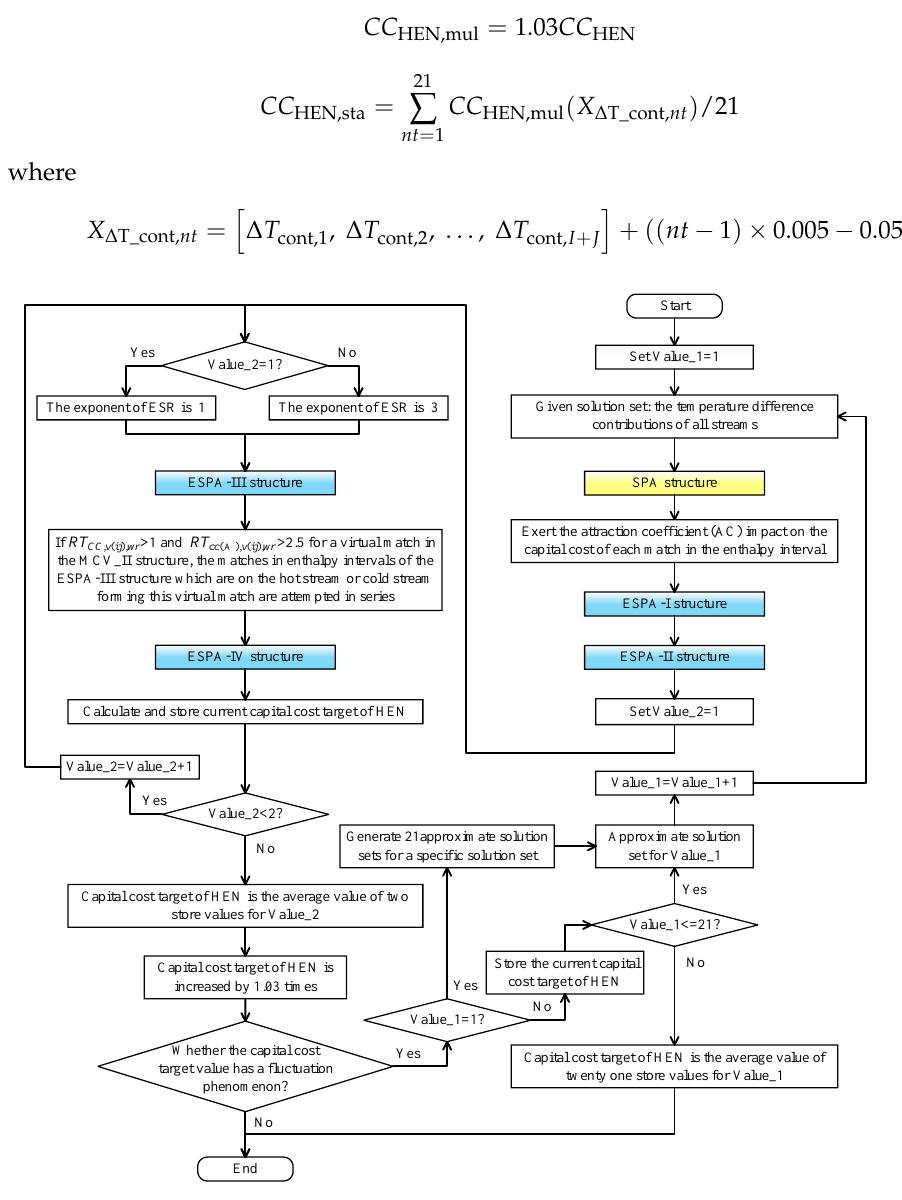
Figure 7. Calculation flowchart of the general ESPA method for capital cost target.